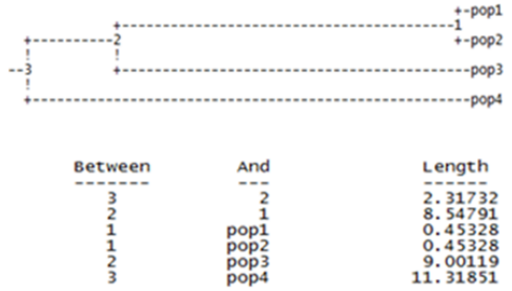
Figure 4. The neighbor-joining dendrogram including the four studied Tunisian breeds. AB: Arab-Barb (pop1); BA: Barb (pop2); AR: Arabian (pop3); and PS: English Thoroughbred